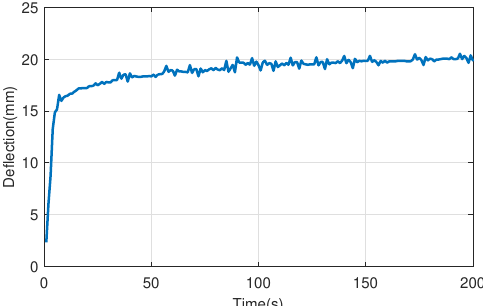
Figure 10. Deflection of the controlled system with multiplicative uncertainty for 22mm reference using a robust PI